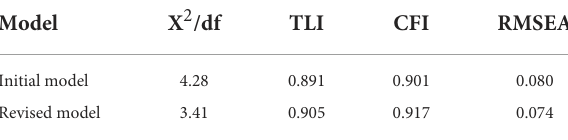
TABLE 5 Dimensions and items of PEPSQ. TABLE 6 The results of the questionnaire’s structural validity